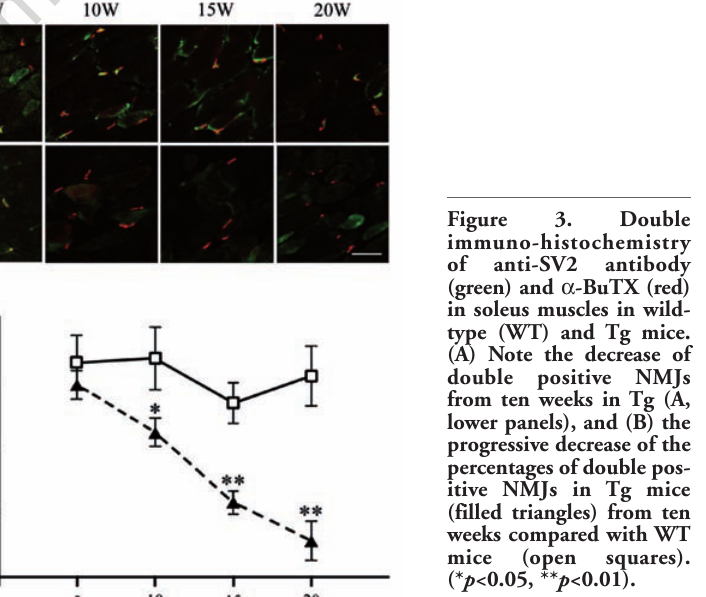
among α -BuTX single positive were not signif- icantly different between WT and Tg mice at